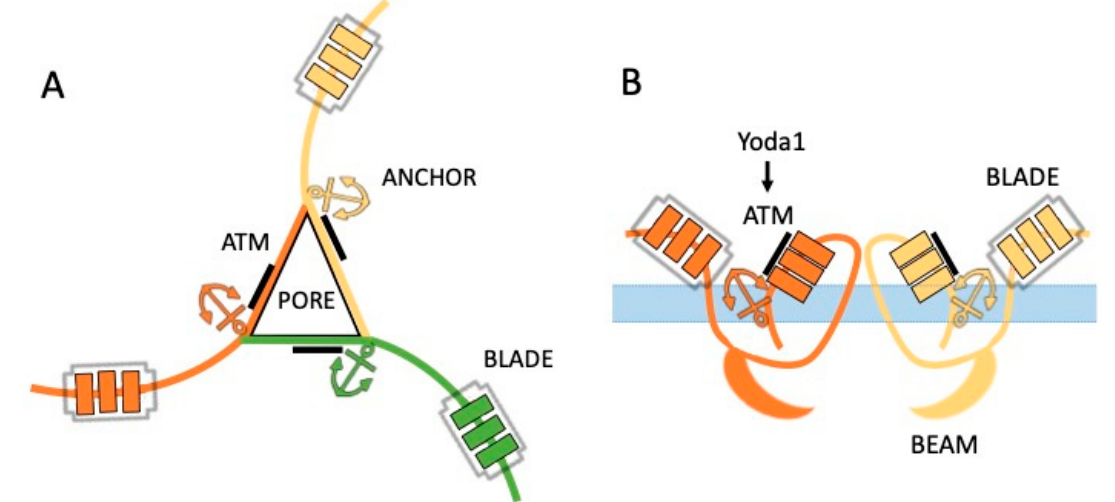
Figure 1. Schematic presentation of the Piezo channel. ( A ) Bird view of the Piezo channel with peripheral blade-like structures located in three subunits forming the trimeric functional unit with the central pore, blades and anchor regions. ( B ) Side view of the Piezo channel located in the lipid cell membrane. The following elements of the single subunit are presented: the intracellular beams, the C-terminals with the anchor regions and the ATM region containing the Yoda1 binding site and the extracellular blades.